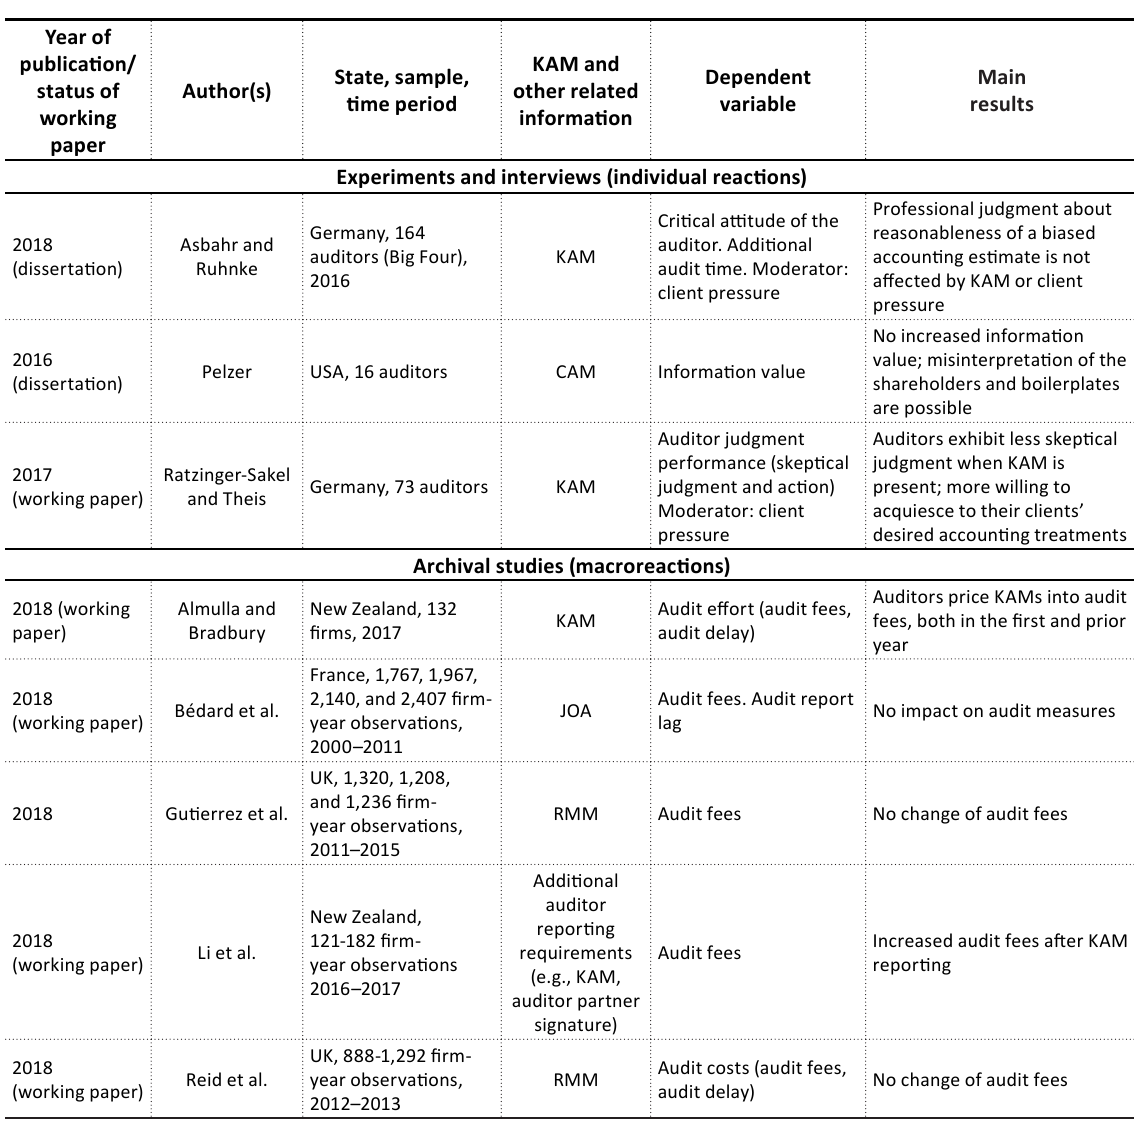
Table 5. Overview of empirical research regarding the impact of KAM and other related information on